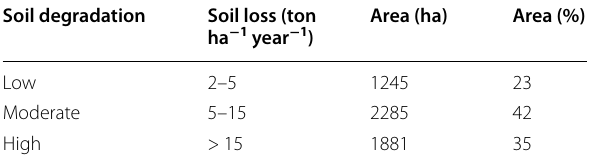
Table 3 Classification of soil degradation in the Ikkour